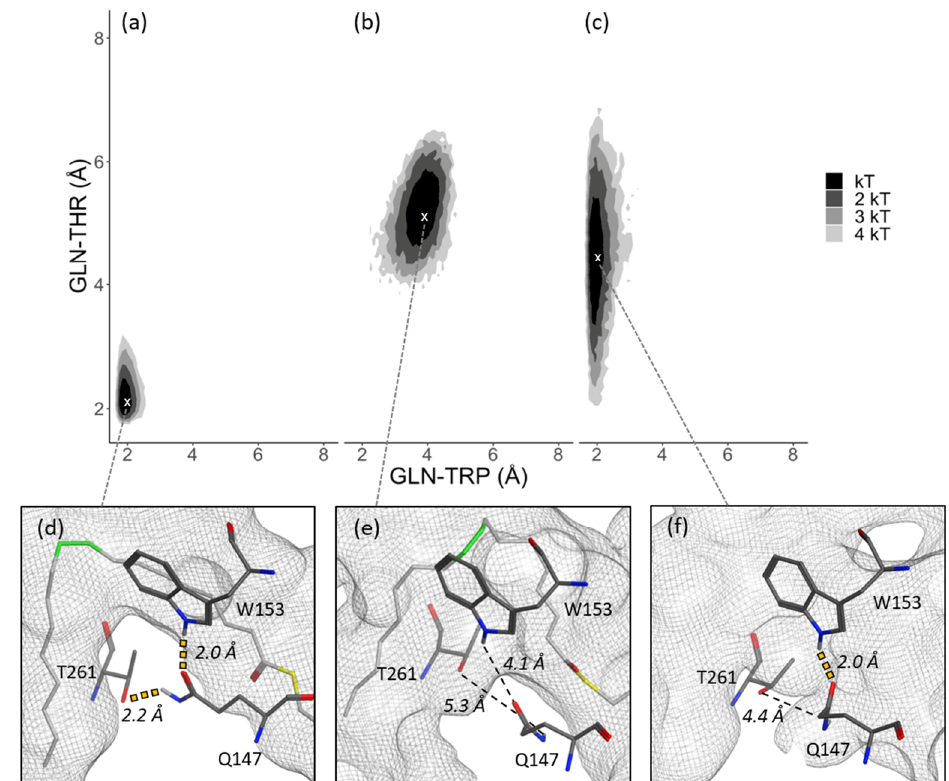
Figure 4. ΔG distribution of the paired Gln-Trp and Gln-Thr distances. ( a ) Substrate simulation 1, ( b ) Product simulation 1, ( c ) Apoprotein simulation 1 models. Minima indicated with white “x”. ( d – f ): Binding tunnel (gray mesh) for each corresponding ΔG minima of a, b, and c, with distances between Gln-Trp and Gln-Thr within hydrogen bonding range (yellow dotted line), and outside of hydrogen bonding range (black dashed line).